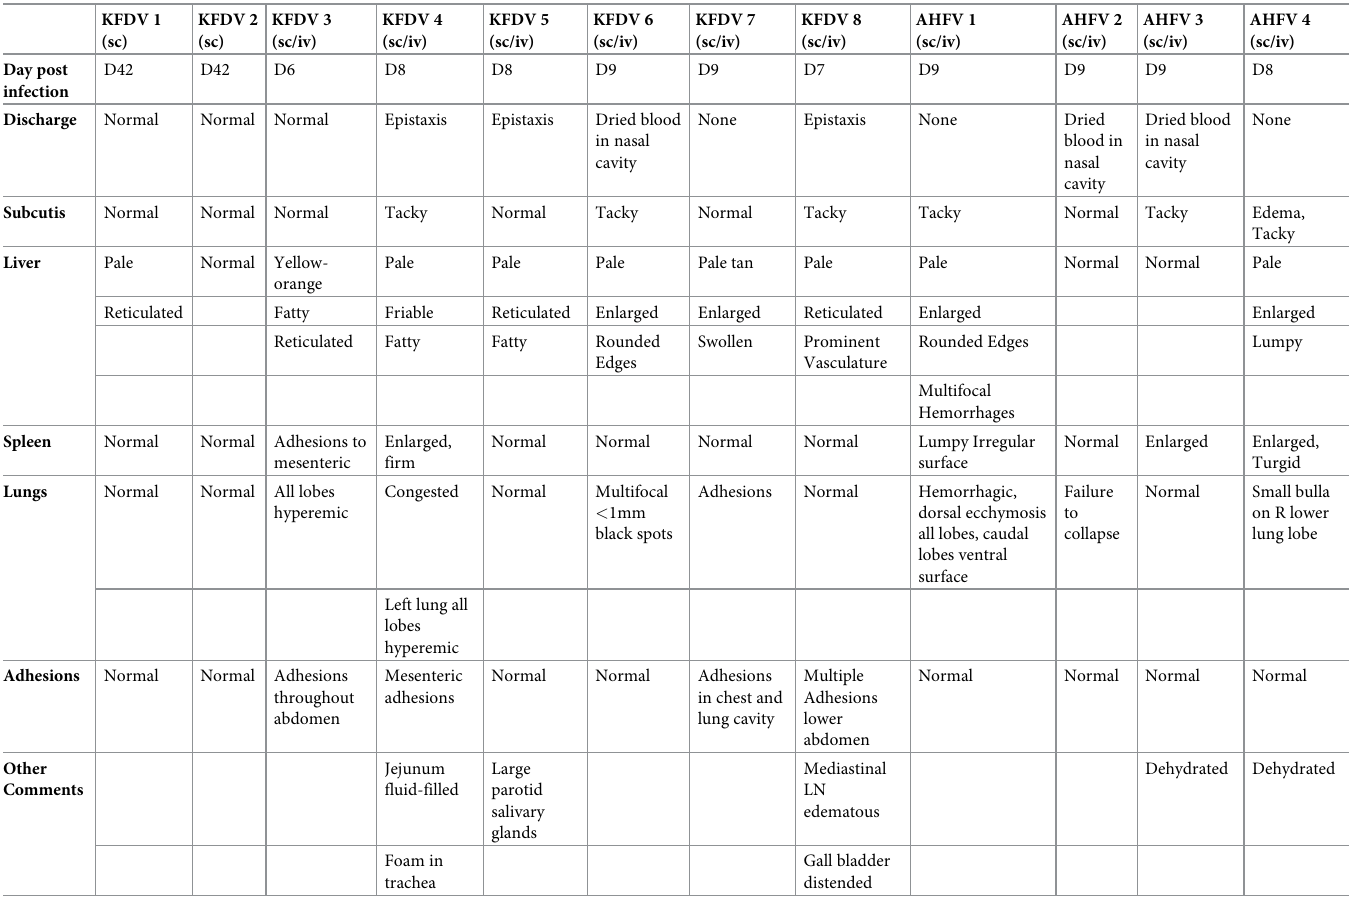
Table 1. KFDV and AHFV Necropsy